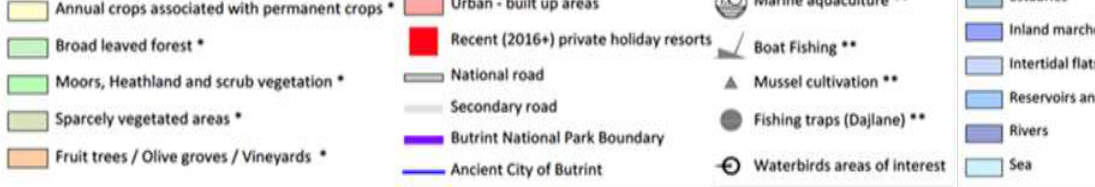
Figure 5: Surface landscape